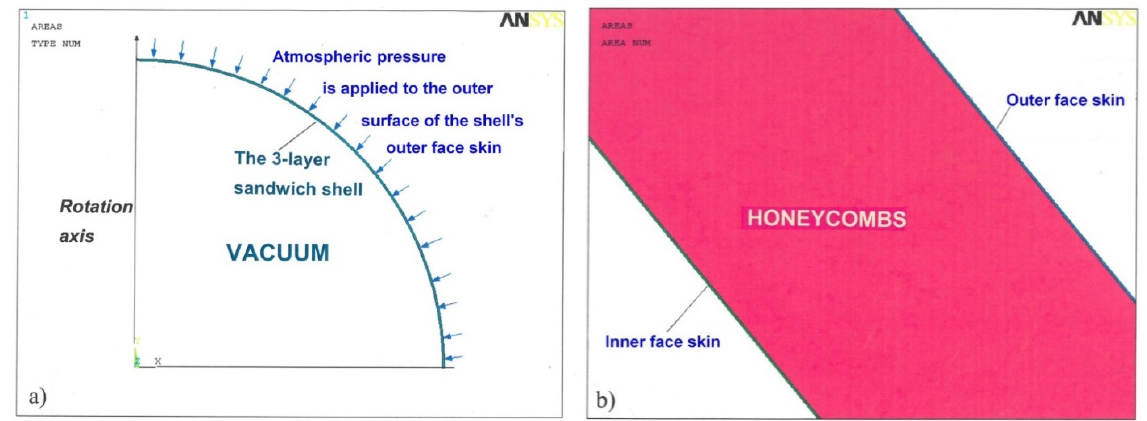
Figure 4. The ANSYS FEA: ( a ) a 2D axisymmetric model and ( b ) an enlarged fragment of the 3-layer sandwich shell’s solid model.